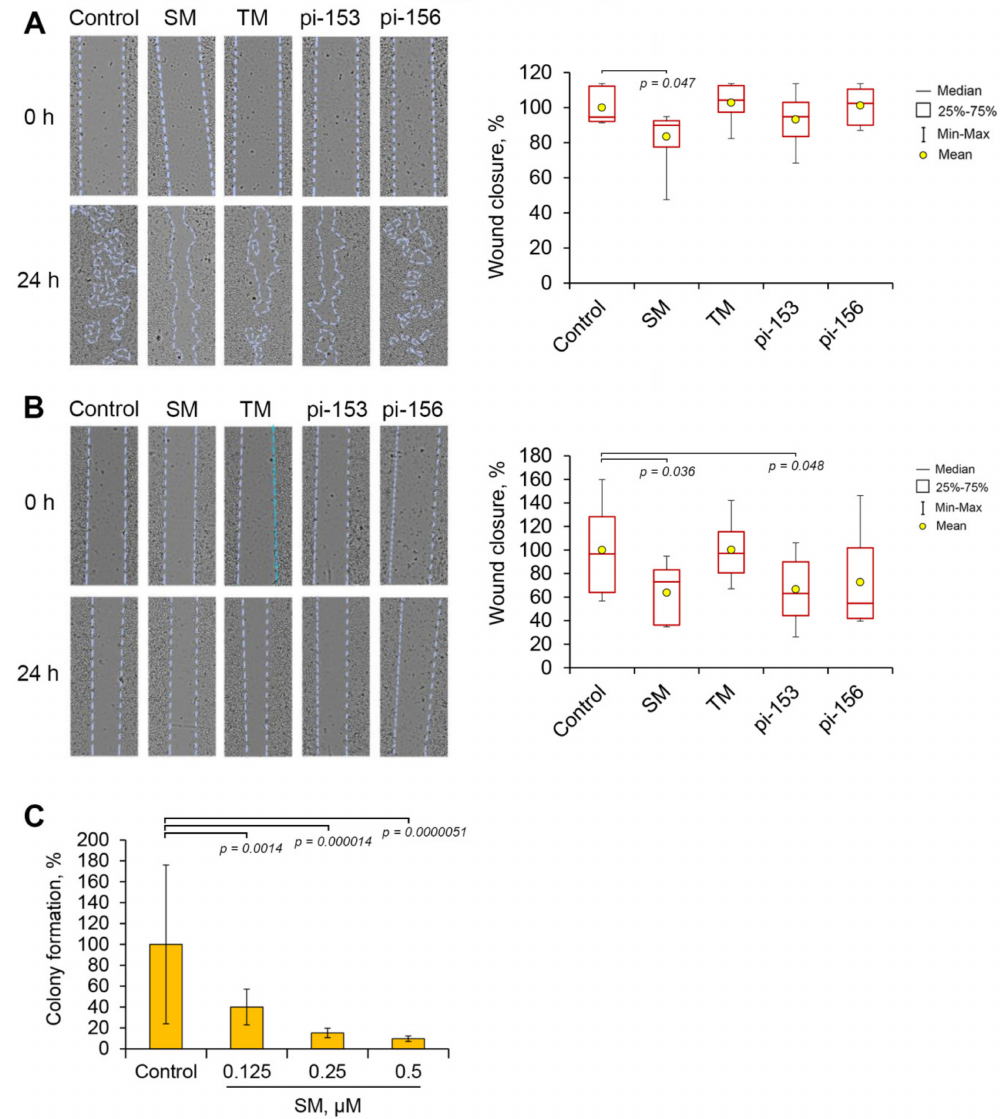
Figure 3. E ff ect of cyano enone-bearing semisynthetic derivatives of 18 β H-glycyrrhetinic and deoxycholic acids on the motility of tumor cells. ( A ) and ( B ). Wound healing assay. The monolayers of B16 ( A ) and A549 ( B ) cells with scratches were treated with investigated compounds at non-toxic concentrations (SM and TM at 0.5 µ M; pi-153 and pi-156 at 50 µ M) for 24 h. Wound closure rates were calculated using ImageJ software. ( C ) E ff ect of SM on clonogenic activity of A549 cells. The cells were seeded at a low density and incubated with the presence of SM for 14 days followed by cell fixation and staining with crystal violet. The calculation of colony formation rate was carried out using ImageJ